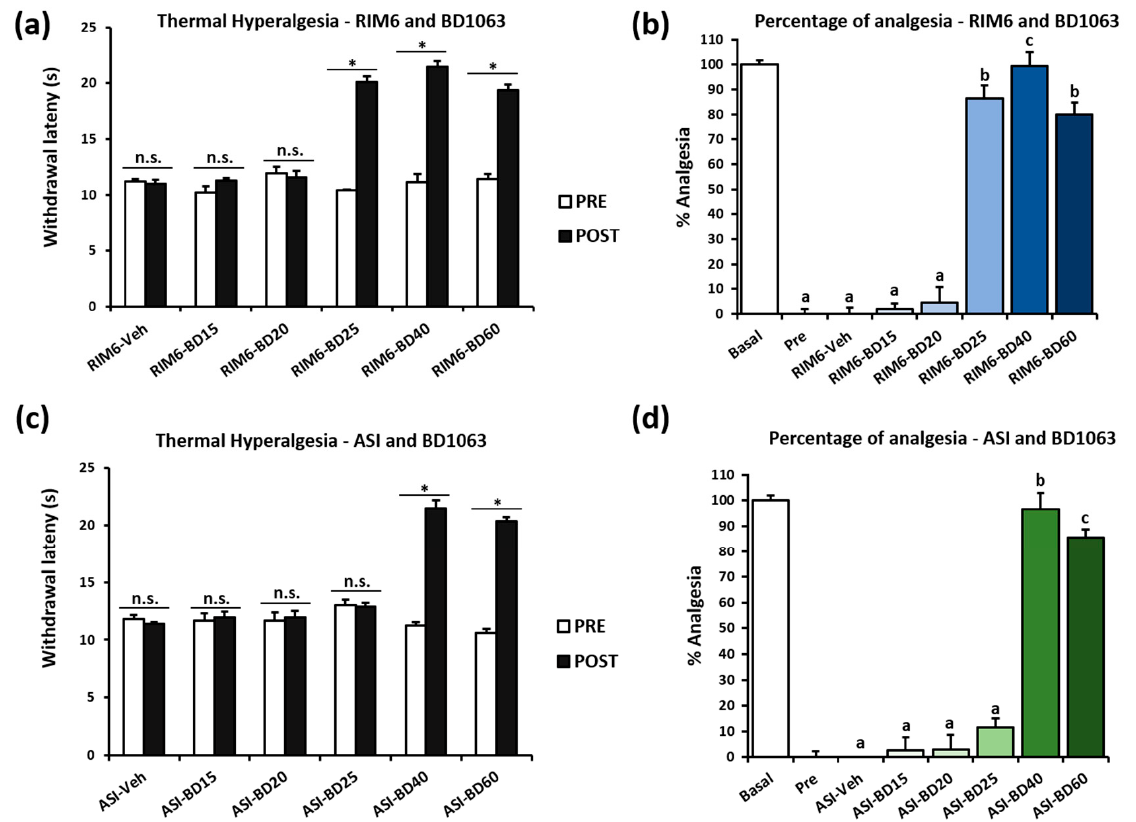
Figure 1. Dose–response effect of BD1063 acute treatment on mice subjected to reserpine-induced myalgia or intramuscular acid saline solution injection. Hind paw withdrawal latency in response to a thermal stimulus before (PRE) and after (POST) BD1063 administration in the ( a ) RIM6 and ( c ) ASI models. Percentage of antinociception 30 min after BD1063 administration in RIM6 ( b ) in ASI models ( d ). Data are expressed as the mean ± SEM ( n = 5 per group). * p < 0.05 PRE vs. POST; n.s. = no significant differences. a–c: Groups not sharing a letter showed significant differences, p < 0.05, determined by post hoc